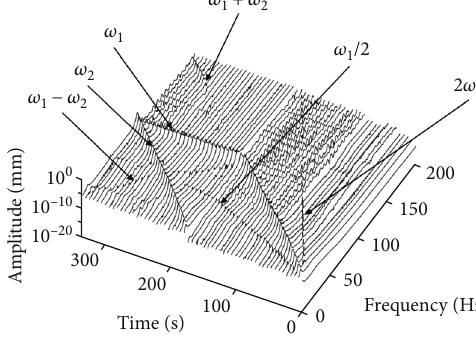
Figure 11: Simulation analysis results: measuring points for PT